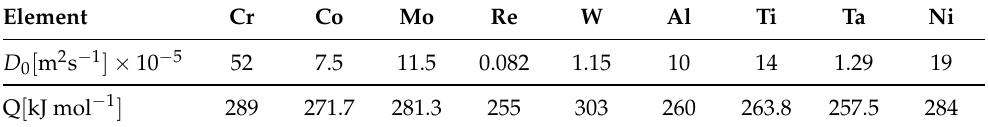
Table 2. Pre-exponential constants and activation energies for solute diffusion in nickel.